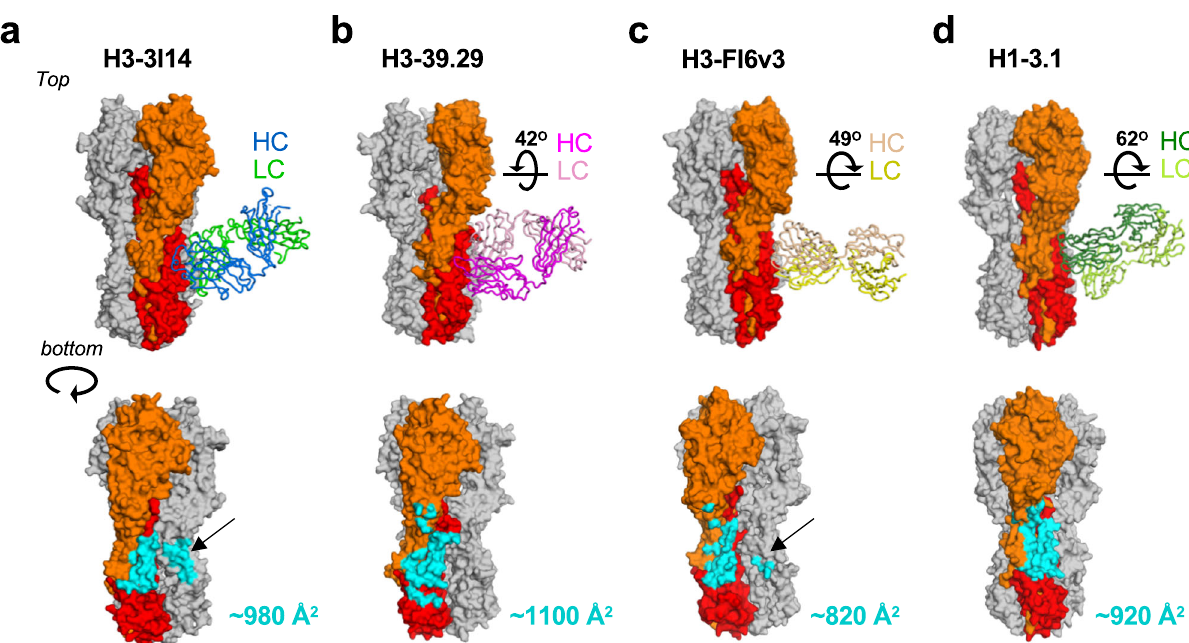
Fig. 5 Angles of approach towards HA for V H 3-30 BnAbs. a – d Top: angles of approach for each of the V H 3-30 antibodies (H3-39.29, PDB 4KVN; H3- FI6v3, PDB 3ZTJ; H1-3.1, PDB 4PY8). HA is shown in surface representation with HA1 and HA2 from the primary protomer colored orange and red, respectively. Each Fab is shown in cartoon representation with 3I14 colored as in Fig. 4, and 39.29, FI6v3, and 3.1 colored according to the labels. The degrees shown in fi gures b – d is the rotation necessary to superimpose the V H domain of that antibody onto the V H domain of 3I14, as determined in Coot. Bottom: HA portion for each complex from the top panel, rotated ~45 o . The buried surface area for each antibody is colored cyan on HA. The black arrows in a and c indicate cross-protomer